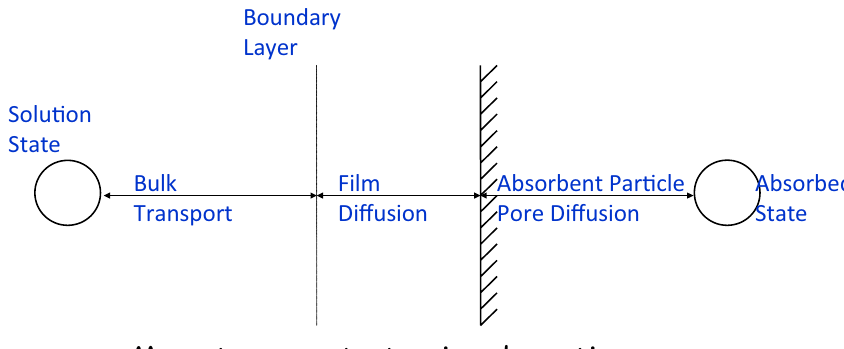
max for temperature and pH